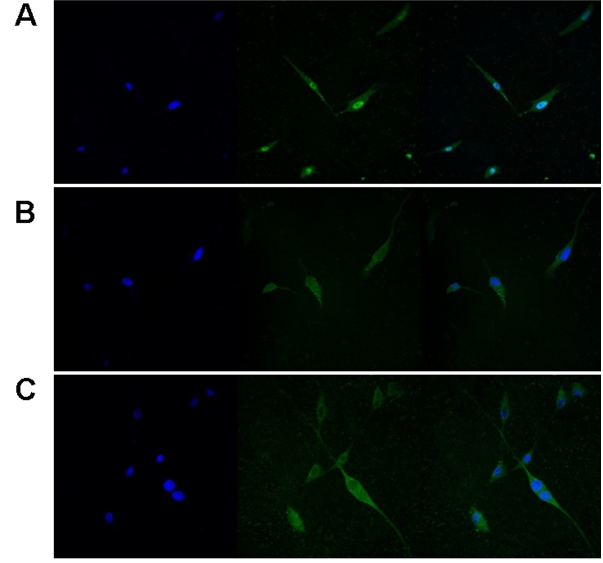
Figure 2. Immunofluorescence stain detection of NFAT1 localization in U87 cells. U87 cells were untreated (A) or treated with CsA (1 m g/ml) or FK506 (100 ng/mg) for 60 min. CsA or FK506 caused NFAT1 (green signals) translocation from nucleus (blue signals) to cytoplasm (B and C).